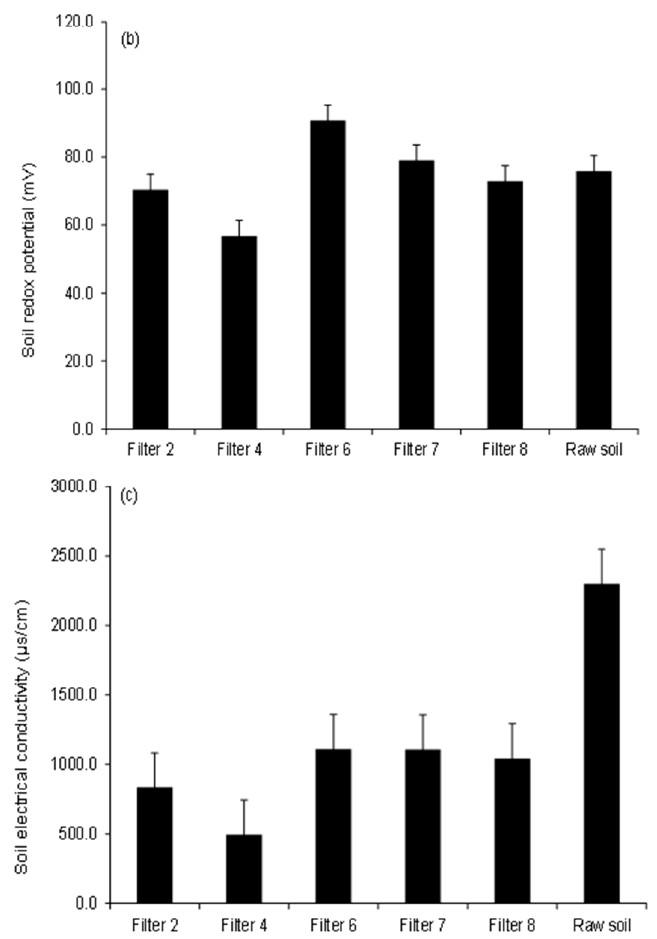
Figure 2. Soil qualities subject to irrigation water: ( a ) pH; ( b ) redox potential, and ( c ) electrical conductivity.